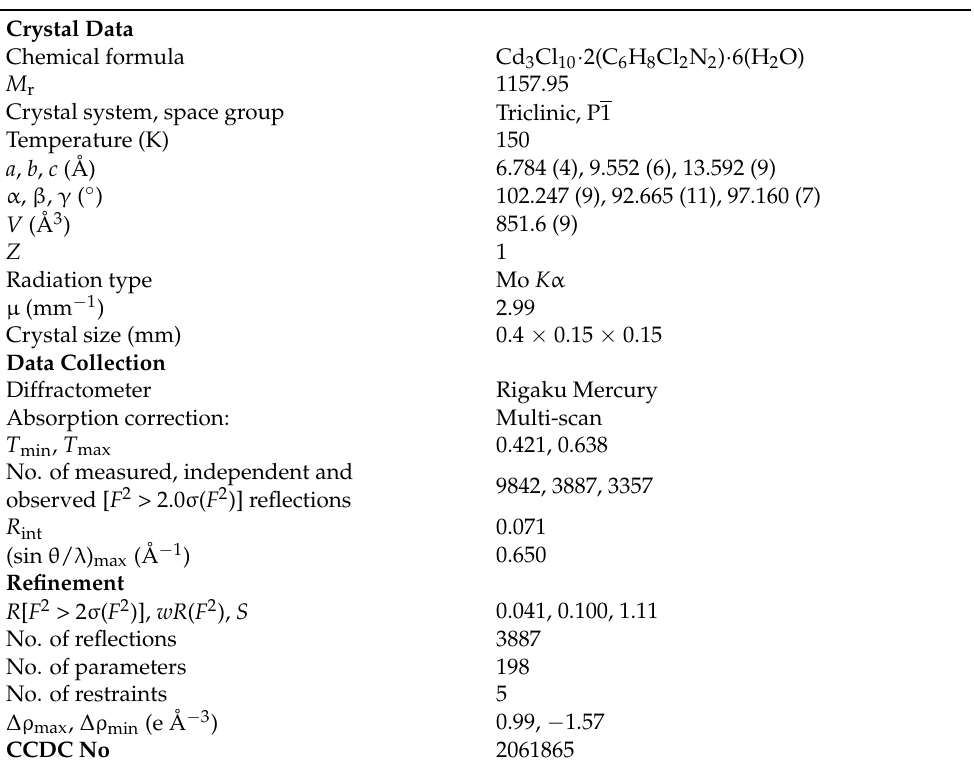
Table 1. Crystallographic